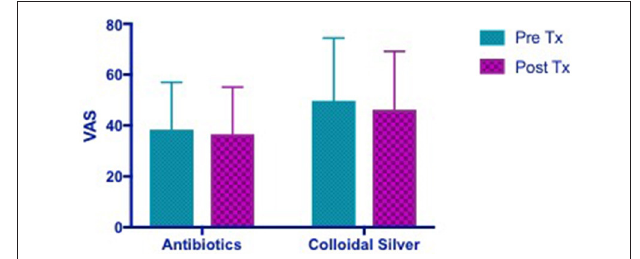
FIGURE 2 | Bar graph showing no significant difference in VAS scores between CON and CS treated groups. VAS, Visual Analog Scale; CON, Control; CS, Colloidal silver.